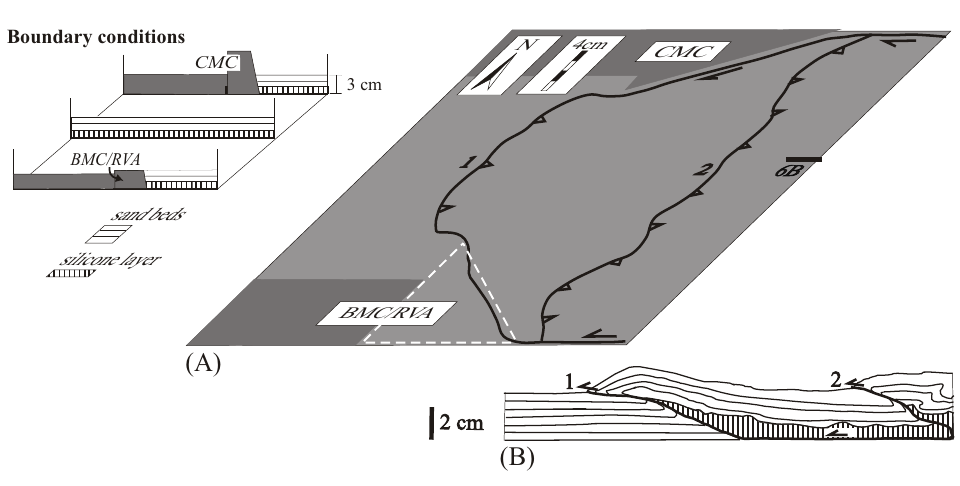
Fig. 6 – Plan-view and profile line drawings of model IV, with a silicone layer simulating a ductile basal detachment. A – The experiment in plan-view after 16% (6 cm) shortening showing the thrust trace of the Fundão-Cambotas Fault System in the foreland (fault 1), and the Água Quente Fault System in the hinterland (fault 2). B – Vertical section in the central portion of the experiment exhibiting the thrust faults in profile view. Numbers indicate the order of fault formation. CMC – Caetés Metamorphic Complex; BMC/RVA – Bação Metamorphic Complex/Rio das Velhas